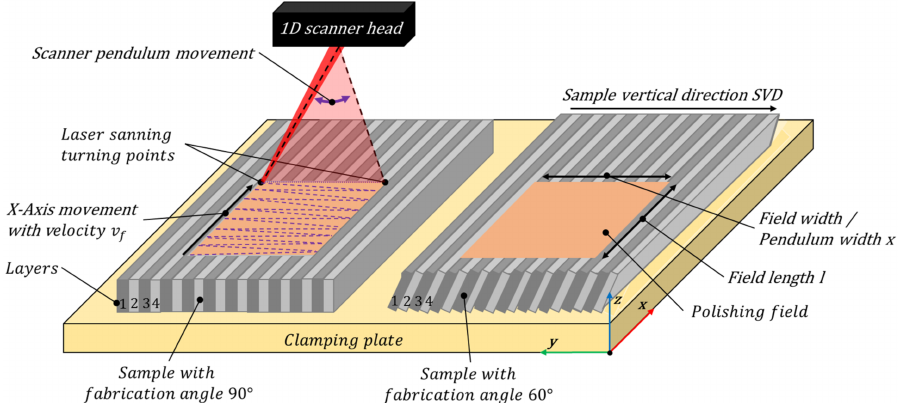
Figure 3. Schematic description of the beam guidance by means of the 1D scanner and superimposed axis movement. Sample orientation on the clamping plate in the process chamber during laser polishing, left: 90 ◦ degree fabrication angle, right: 60 ◦ degree fabrication